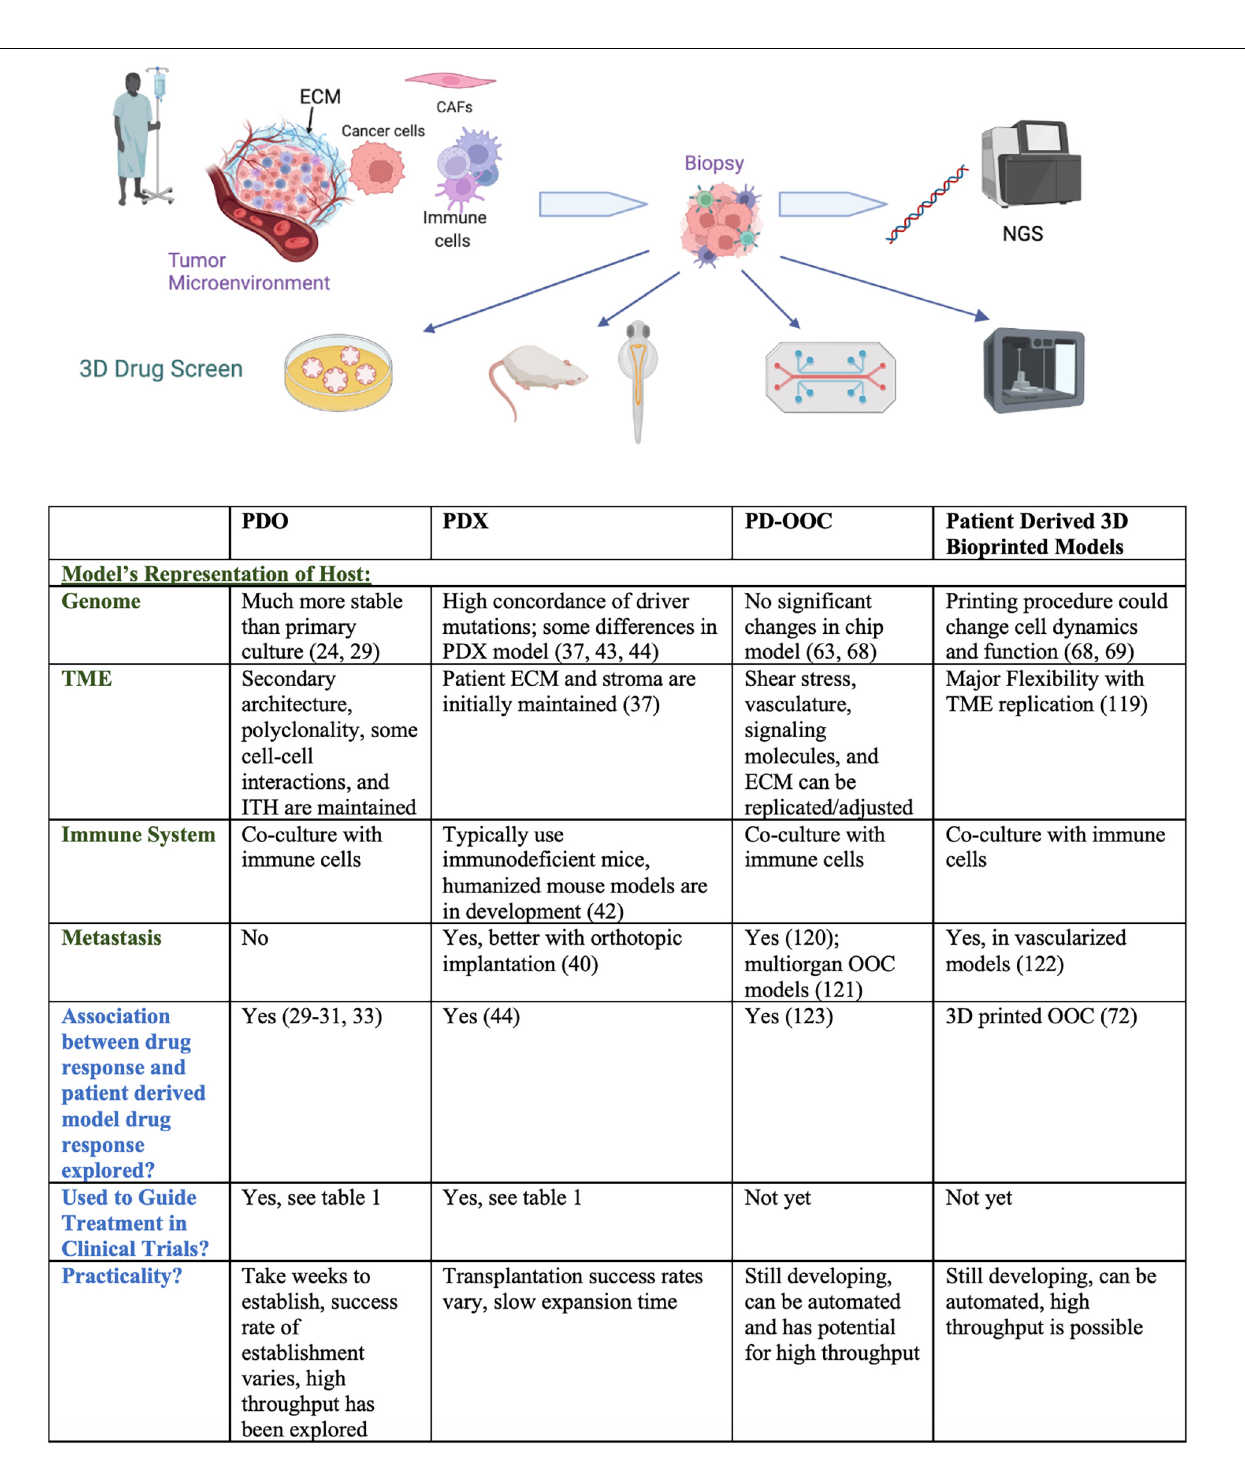
(43). A study comparing the genomic landscapes of 536 PDX models with their parent tumors revealed high tumor purity and sub-tumor clone selection in PDXs compared to primary human tumors, high concordance of driver mutations in PDXs